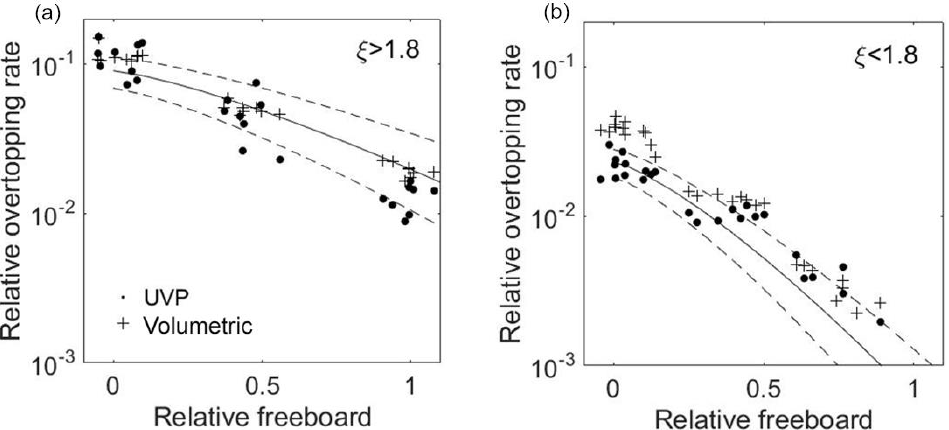
Figure 9. Relative overtopping discharge obtained from UVP (dot symbols) and from volumetric measurements (cross symbols), compared with the EurOtop formulae (5% under and upper exceedance limits in dotted lines). Panels ( a ) and ( b ) show tests with Irribarren factor ξ greater and less than 1.8, corresponding to the offshore slope equal to cot(α off ) = 2 and 4, respectively.